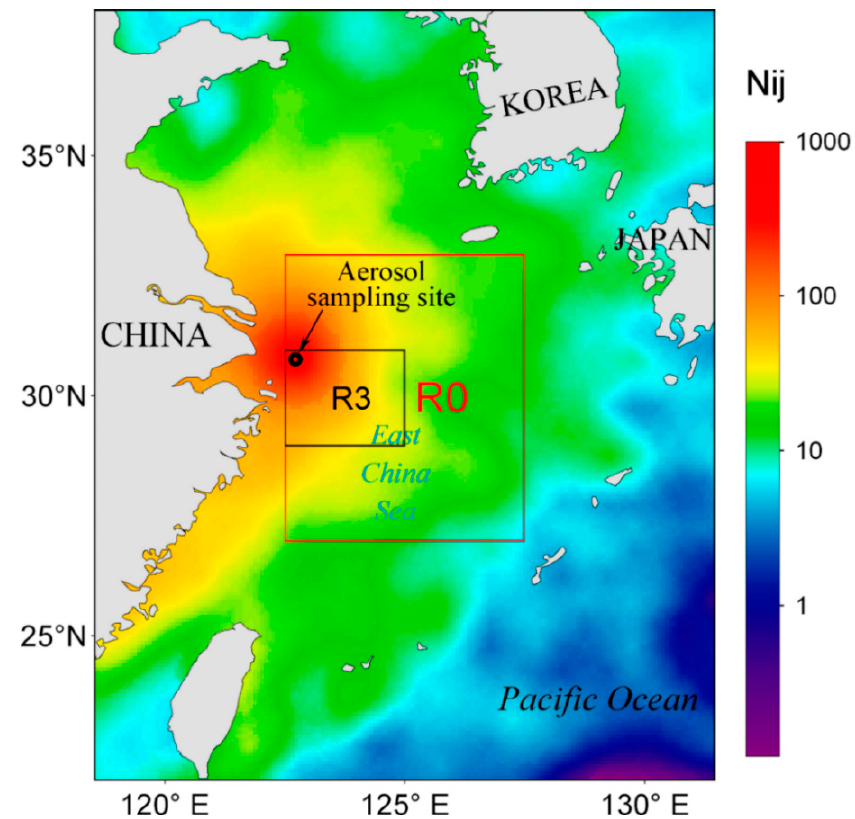
Figure 2. The oceanic region influenced by the air masses started from the aerosol sampling site in the spring months (March, April, and May) of 2011–2015. Kriging interpolation was applied to obtain a gradual